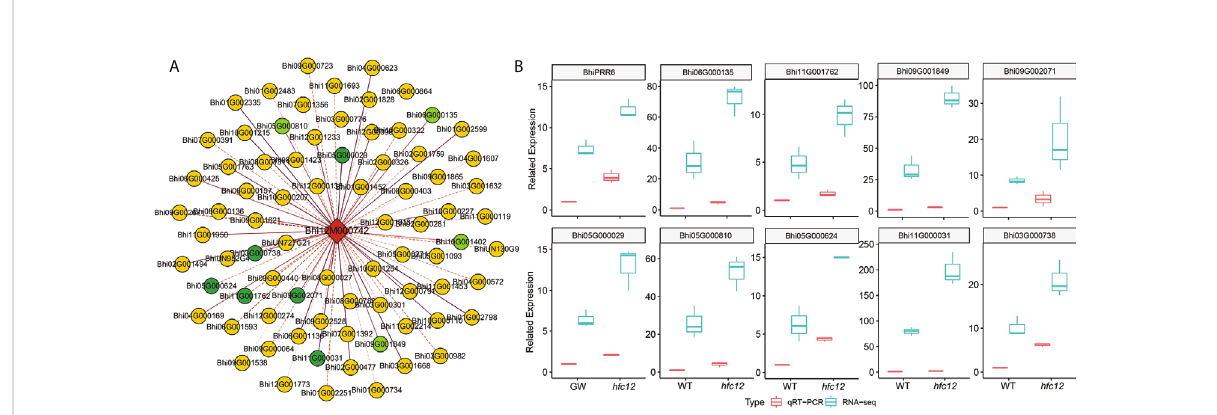
FIGURE 5 Co-expression regulatory network and expression of BhiPRR6 and other interacting genes in wax gourd. (A) Co-expression network analysis with BhiPRR6 as hub gene. The light-green circles represent the genes with the highest correlation (Topological overlap matrix, TOM > 0.52). The dark-green circles represent the candidate genes that may regulate the synthesis of fl avonoids with BhiPRR6 (Table S5). (B) The expression pattern of BhiPRR6 and ten co-expressed genes by both Quantitative real-time PCR (qRT-PCR) and RNA-seq